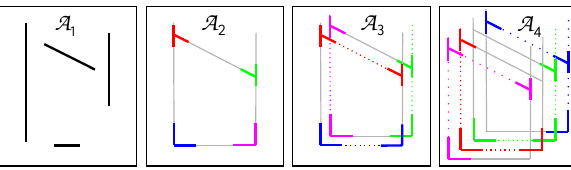
Figure 3: (Best viewed in colour) Toy example to visualize the meaning of aggregates of lines. We start from lines collected in the set A 1 . Aggregates of A 2 are given by line junctions; each aggregate is shown in a different colour. Aggregates of A 3 are groups of three lines, thus elements of A 2 joining one line. They are visualized by two A 2 aggregates joining the same colour. Overlapping aggregates are shown behind each other. Ag- gregates A 4 with four lines are built accordingly to the previous lines, adding one line to all elements in A 3 . Thus they are junc- tions of four lines, visualized by three A 2 aggregates joining the same